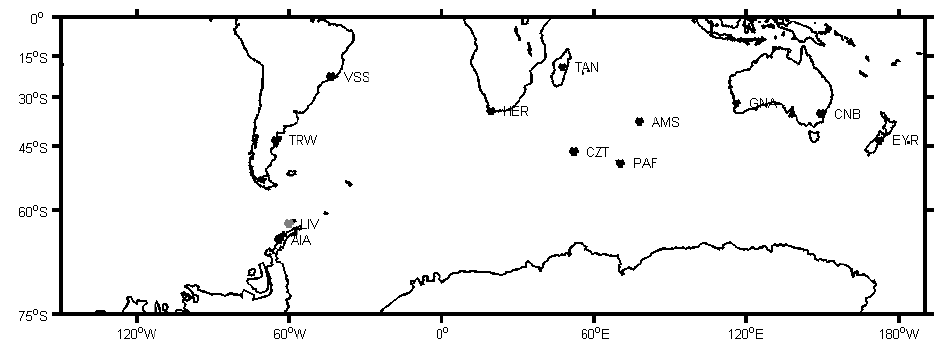
Figure 2. Local distribution of magnetic observatories in the neighbourhood of our test station, Livingston (LIV), used in the option two in the training process of the network.